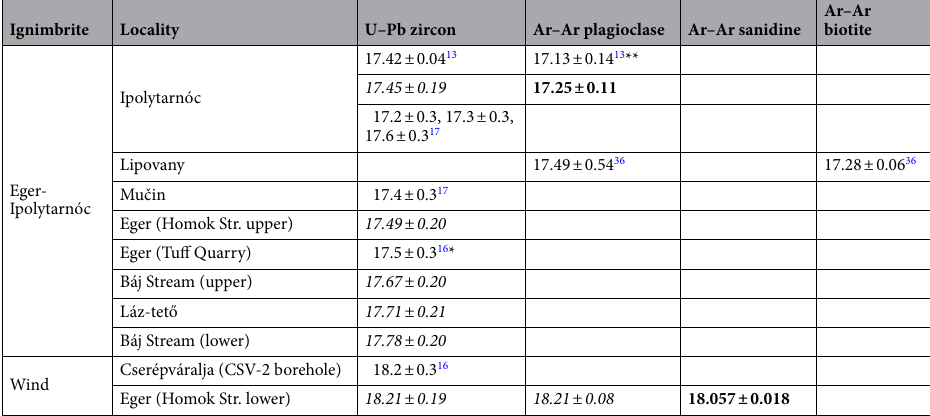
Table 1. Ar–Ar and U–Pb ages from the Wind and the Eger-Ipolytarnóc ignimbrites. Values in italics are determined in this paper, the other ones are taken from literature. Uncertainties are given in 2σ. *Average of 2 datings. **Corrected from 17.02 ± 0.14 Ma using the revised Fish Canyon Tuff age ( 51 Kuiper et al. 2008). Preferred eruption ages are in